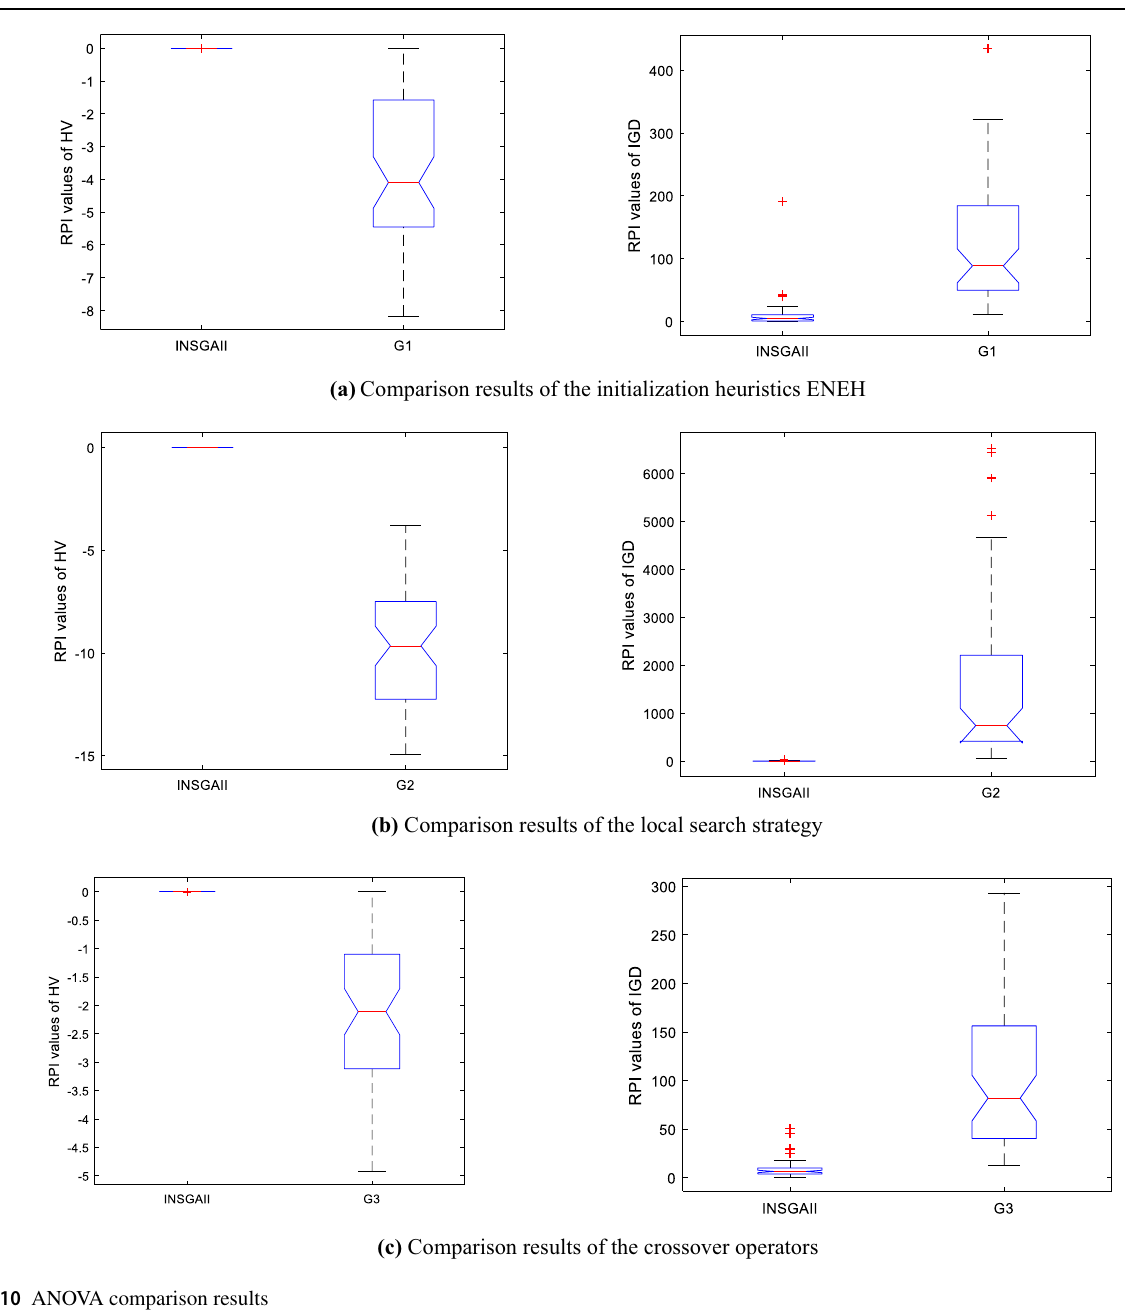
Fig. 10 ANOVA comparison